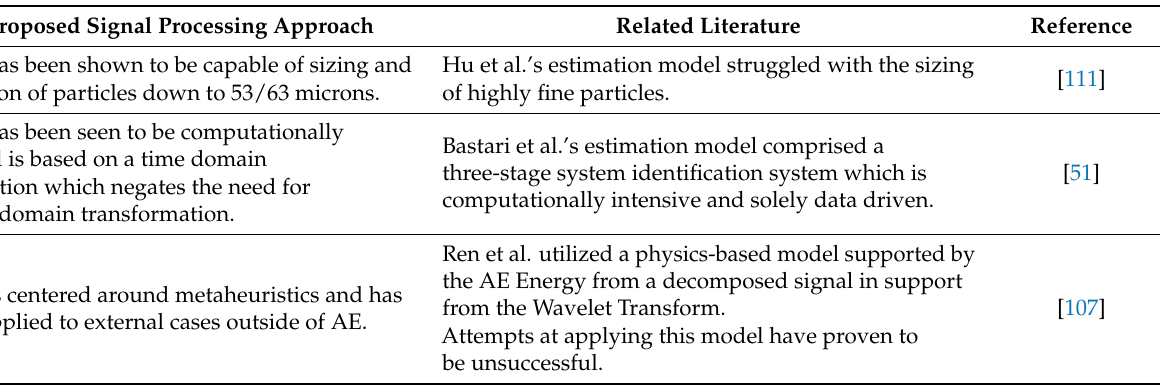
Table 2. Comparison of LSDL/proposed signal processing approach against the related